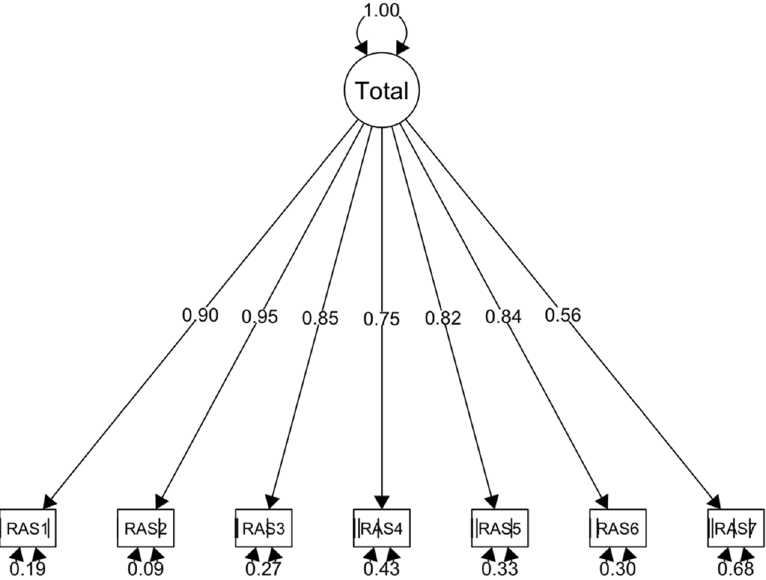
Figure 1. The path diagram of the one-factor model of the Polish RAS in the Polish reference sample (N = 733). RAS Relationship Assessment